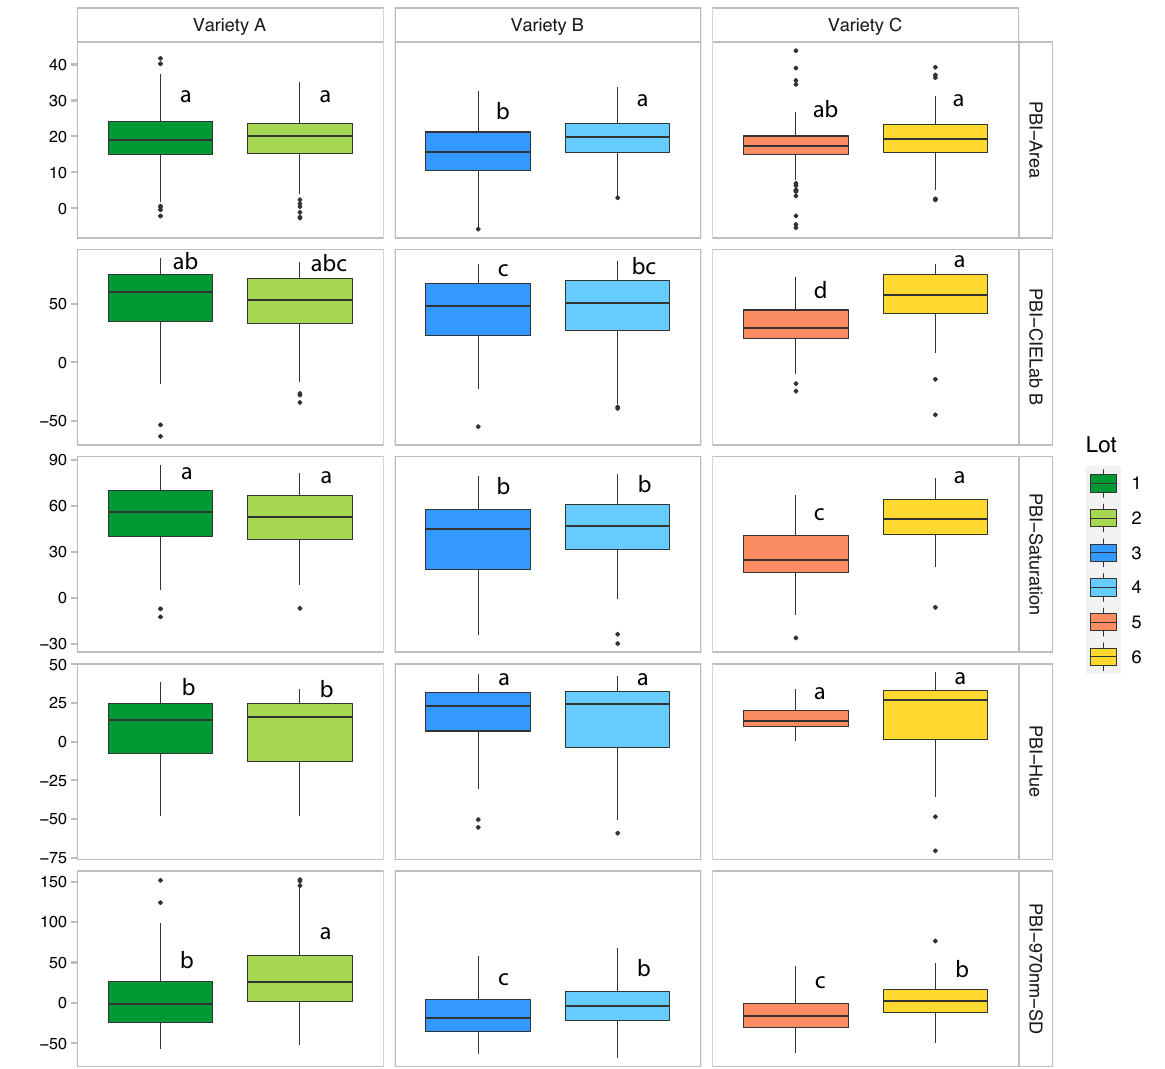
Figure 4. Selected VideometerLab features presented as percentage change in the feature levels post-blindness induction (PBI) relative to initial dry seed analyses for the same seeds. Letters indicate significant differences among all lots for each parameter (rows) as calculated by ANOVA and Tukey